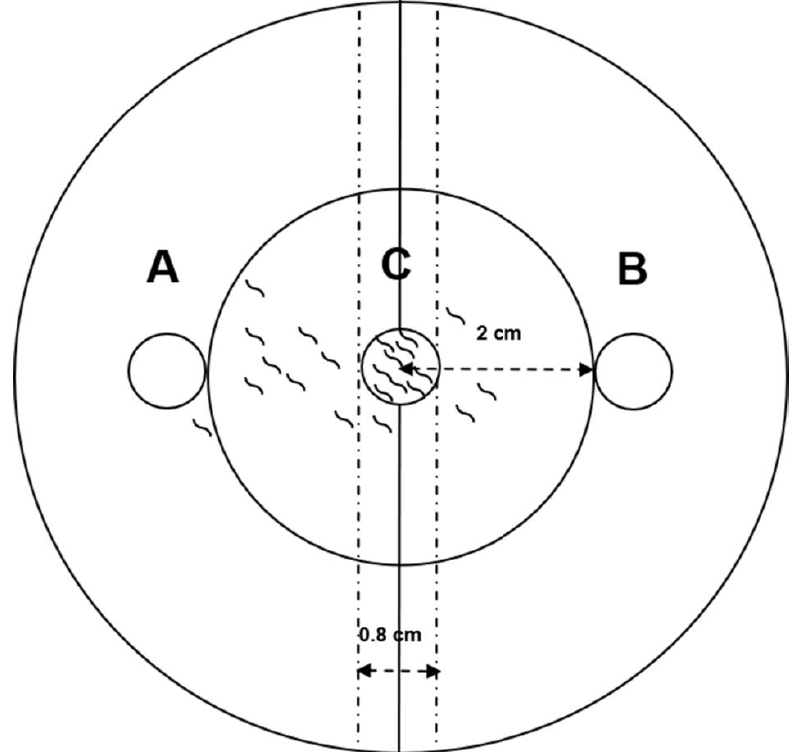
Figure 5. Chemotaxis mode. ( A ) Test location, ( B ) control location, and ( C ) center of the plate.